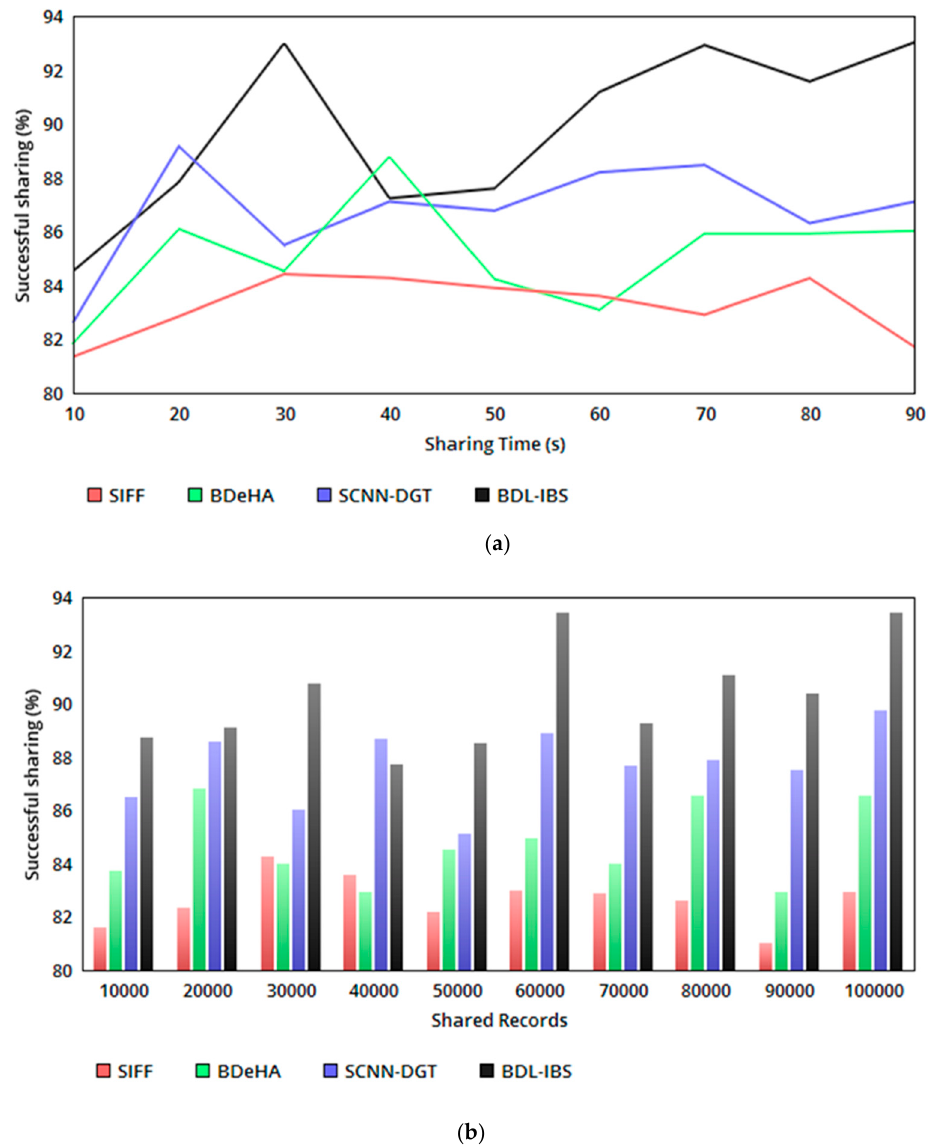
Figure 4. ( a ) Successful sharing ratio versus sharing time. ( b ) Successful sharing ratio versus shared